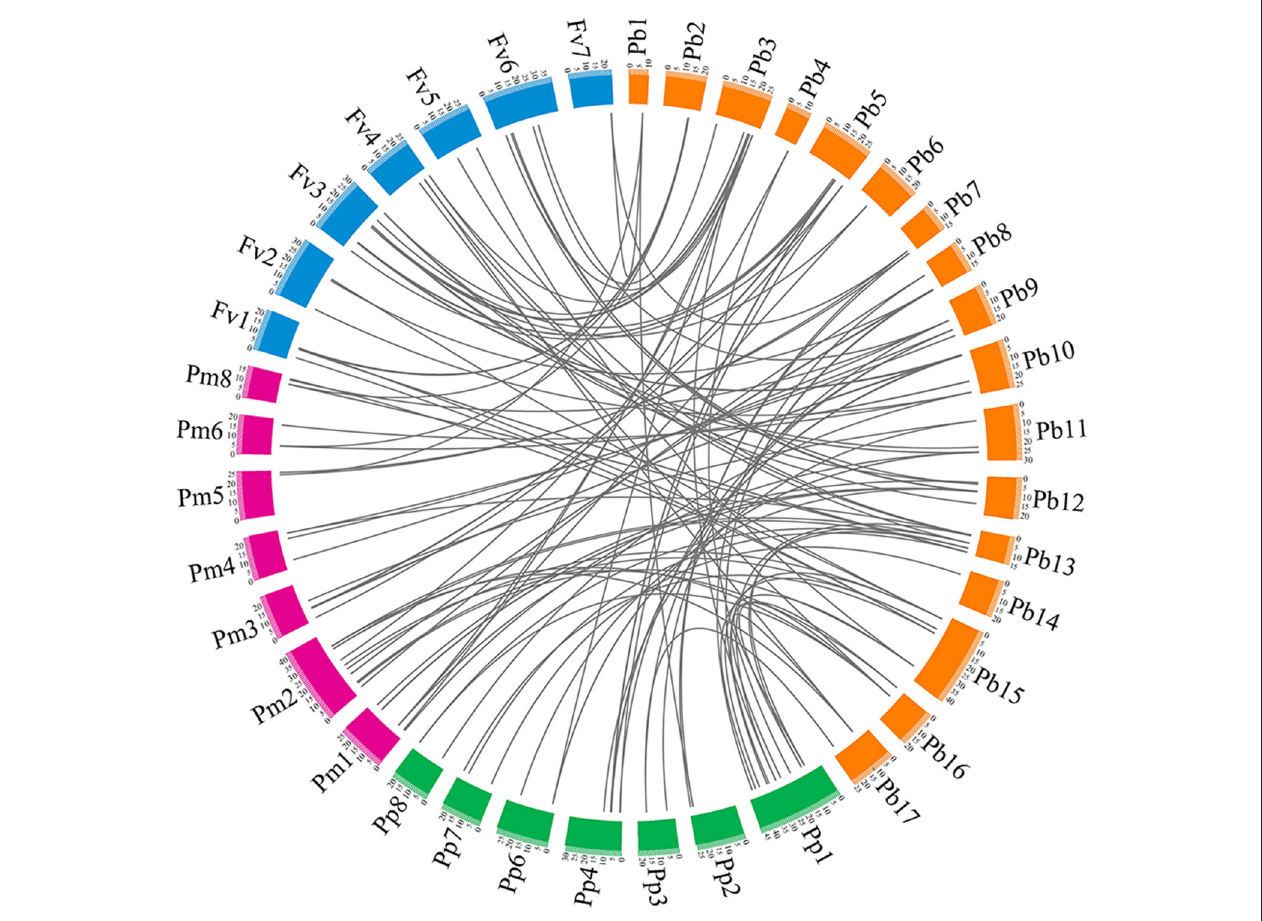
FIGURE 4 | Microsynteny of PRX regions across pear, yang mei, peach, and strawberry. The pear, yang mei, peach and strawberry chromosomes are shown in different color boxes, as well as labeled Pb, Pm, Pp, and Fv, respectively. Syntenic relationships between PRX regions are represented by gray